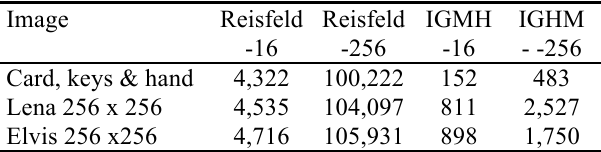
Table 2. Bilateral Symmetry Detection Time (ms).